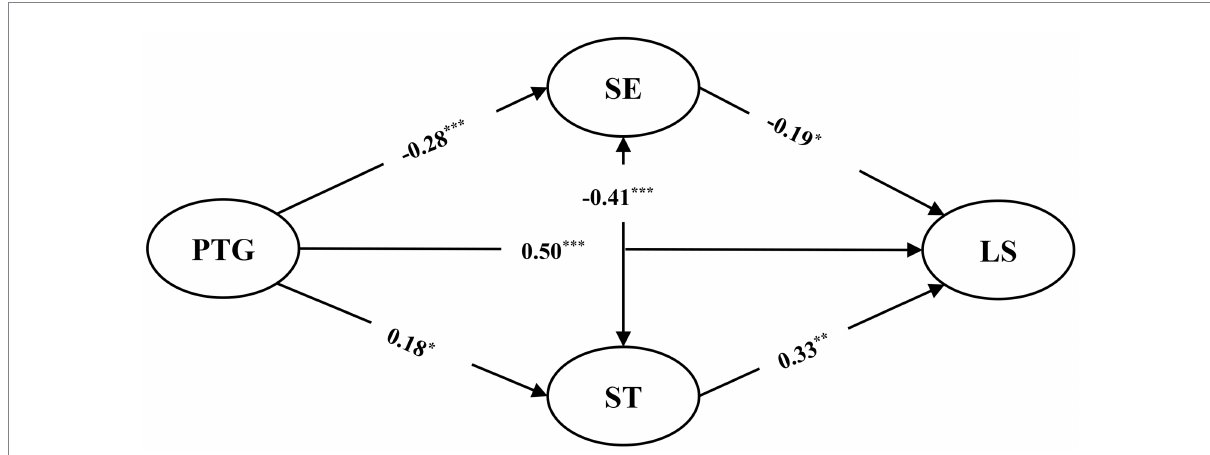
FIGURE 2 The mediation model of SE and ST values between COVID-19 related PTG and LS. Path coefficients are standardized. * p < 0.05, ** p < 0.01, *** p < 0.001.